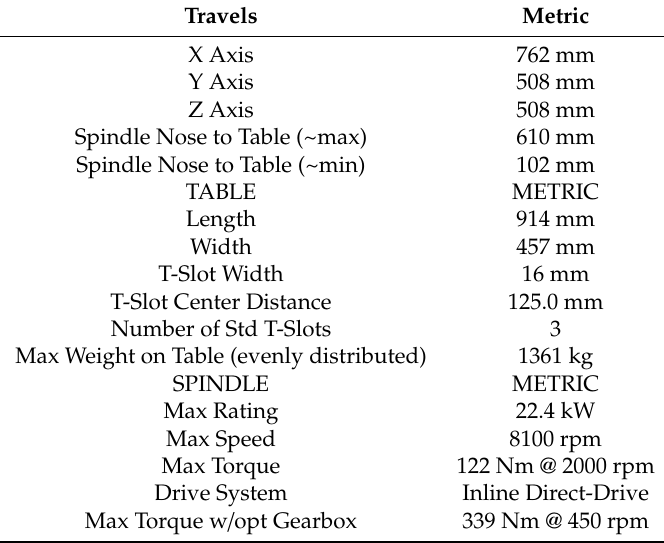
Table 4. HAAS VF-2YT specifications